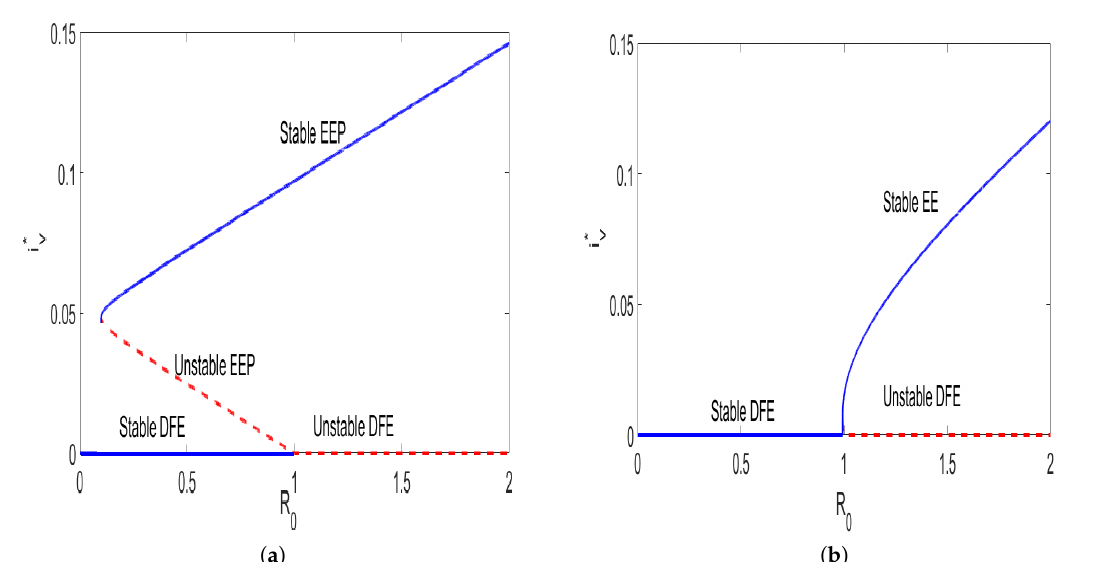
Figure 1. Graphical results illustrating the possible bifurcations for model (3) for different values of awareness campaigns θ h . The figures were generated with parameter values taken from Table